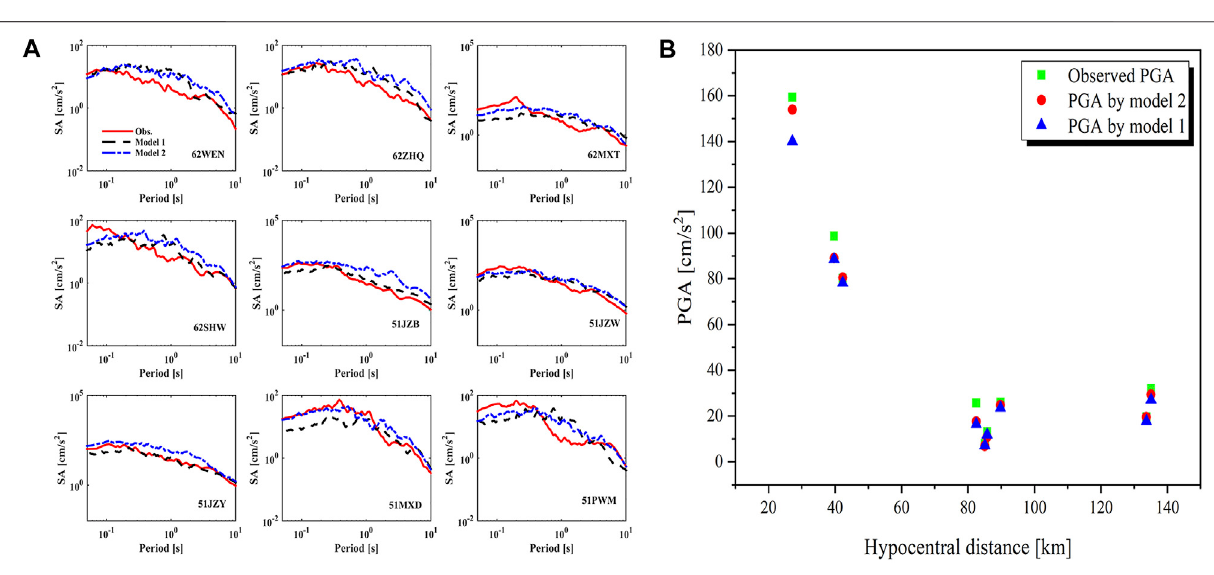
FIGURE 6 | (A) Comparison of the observed and simulated SA for the nine stations in the Jiuzhaigou earthquake; (B) Comparison of observed, simulated PGA valuesbythetwocornerfrequencymodels.SimulatedSAsandPGAsaretheaverageof30trialsforeachcase.TheredsolidlinerepresentstheobservedSA.Theblack dashed line and the blue dashed line represent the simulated SA obtained by the static corner frequency (Model 1) and the dynamic corner frequency (Model 2), respectively. The green rectangle stands for the observed PGA. The red circle and blue triangle represent the PGA simulated by the dynamic and static corner frequency models,